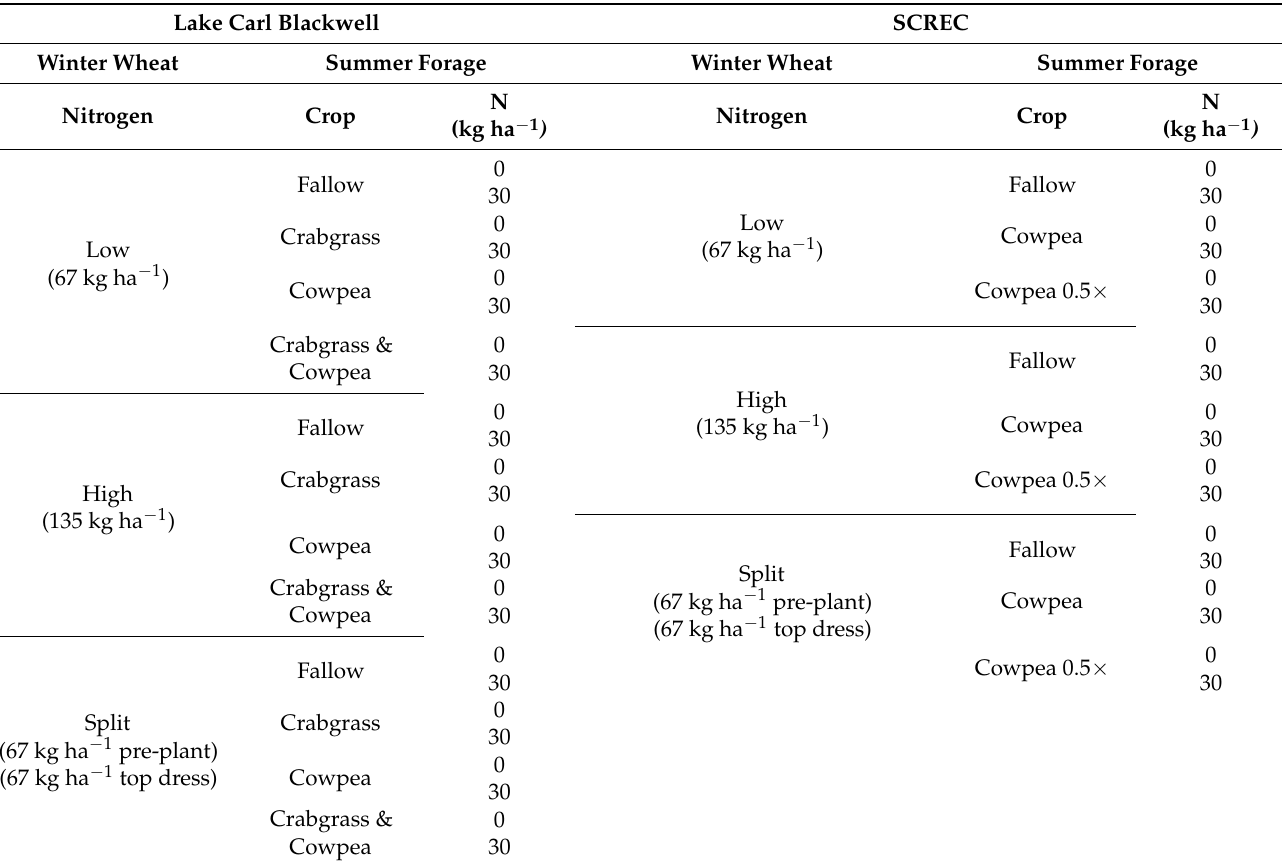
Table 1. Continuous winter wheat forage treatment structures for Lake Carl Blackwell (Left) and SCREC (Right). Winter wheat N rate at pre-plant and top-dress timings in kg N ha − 1 , summer forage crop species, and summer N application rate in kg ha − 1